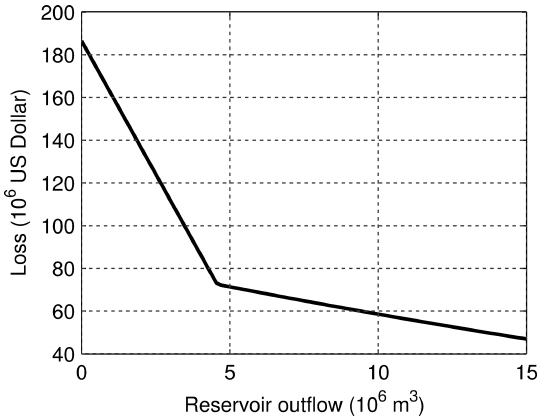
Figure 3. Loss for municipal water users as a function of reservoir outflow (for 1month), based on reference water